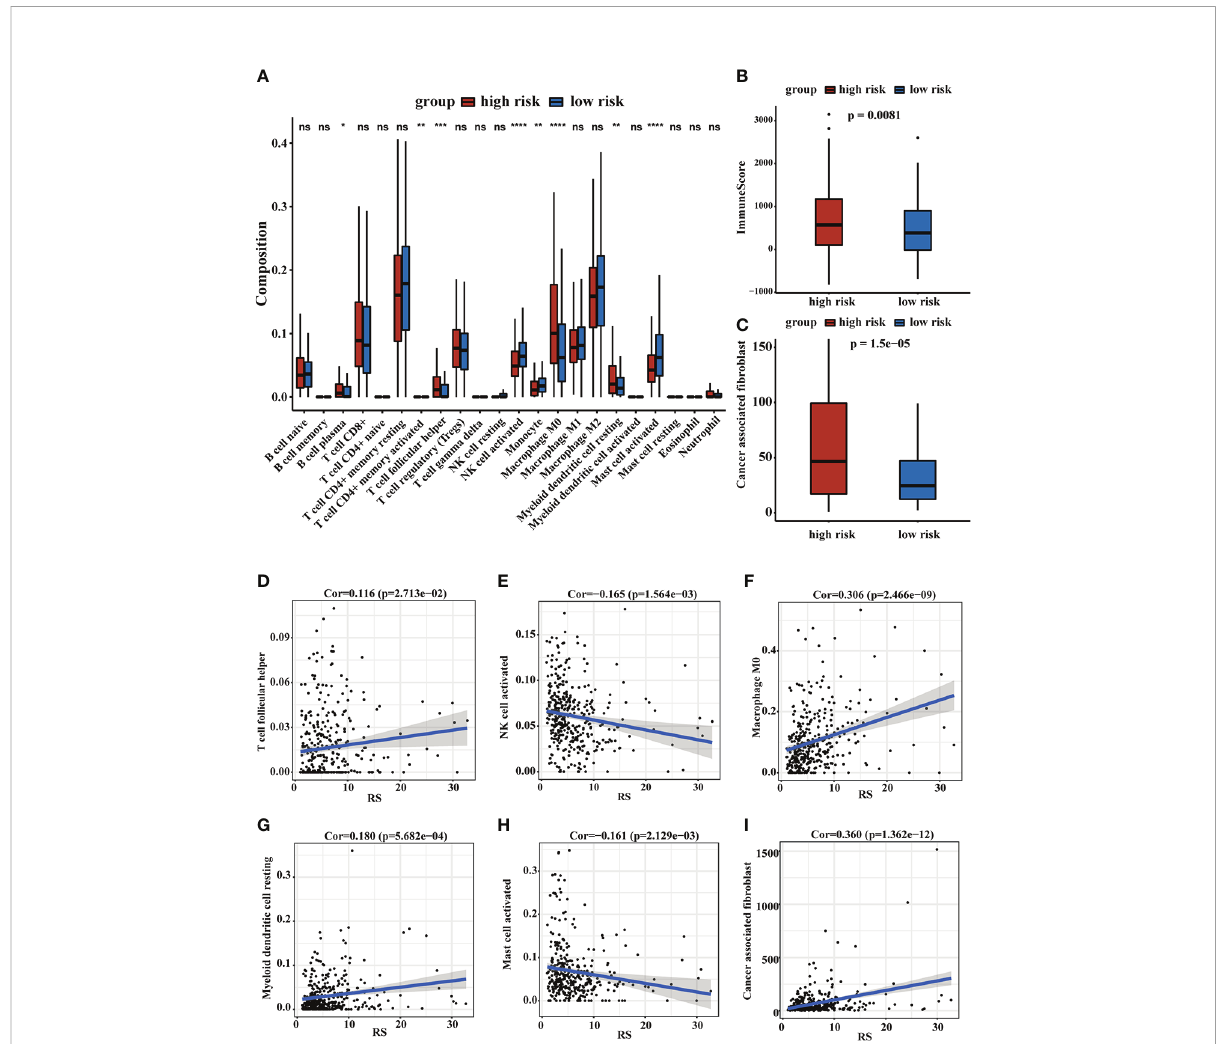
FIGURE 6 The landscape of TME. (A) The relative cellular abundance of immune cells was calculated by CIBERSORT. (B) The ImmuneScore was calculated by ESTIMATE. (C) The relative in fi ltration degree of CAFs between the two groups. (D – I) The correlation analysis of immune in fi ltrating cells and RS. ns, no signi fi cance, *P < 0.05, **P < 0.01, ***P < 0.001, ****P <